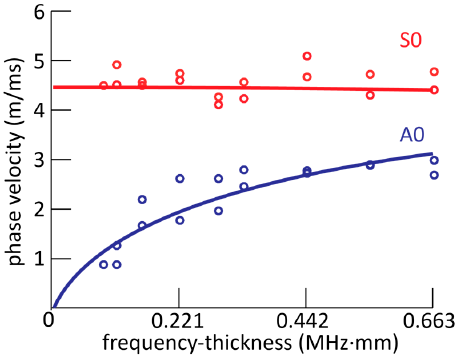
Figure 7. The data points represent the measurement dispersion curve, determined using the MOFBG a Lamb wave sensor in the small, slender CFRP panels. The solid lines indicate the calculated dispersion curves.